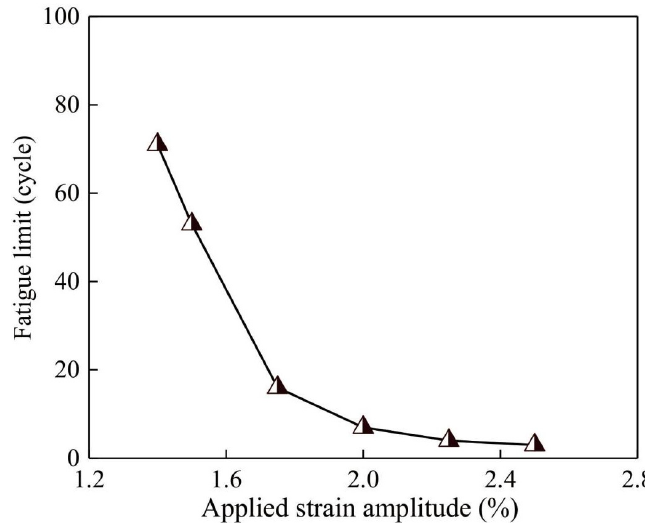
Figure 9. Fatigue limit as a function of applied strain amplitude. For the sample which has a fatigue limit higher than 100 cycles, data are excluded in this figure.